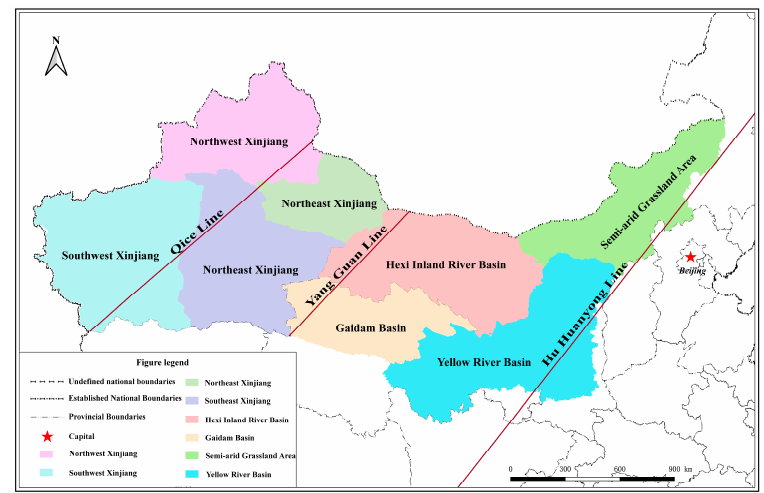
Figure 1. ‘Three Water Lines’ area of northwest China.